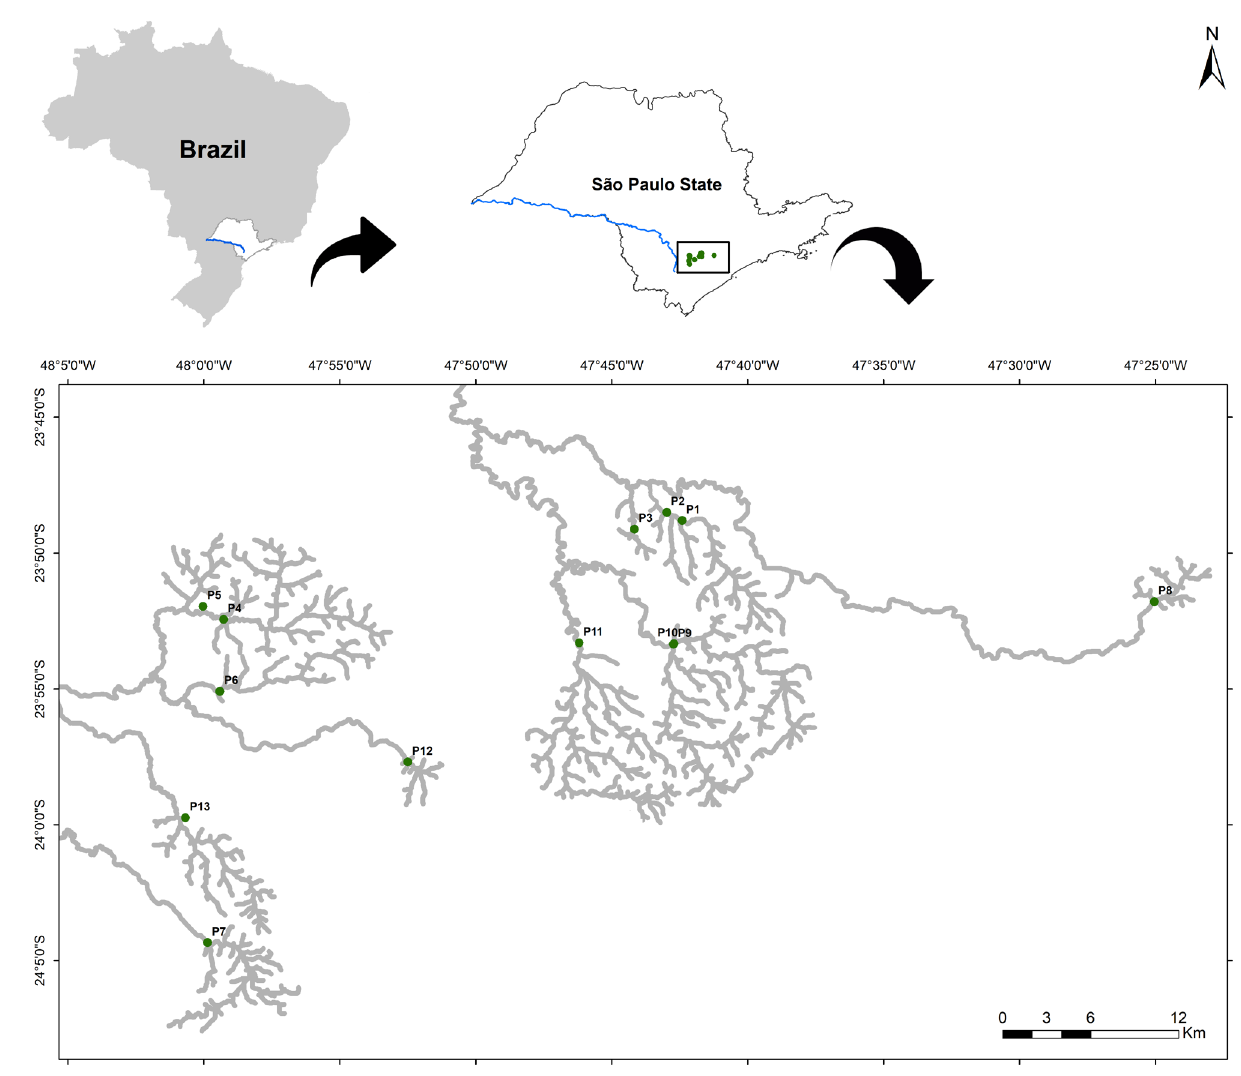
FIGURE 1 | Sampling sites located in the Paranapanema river basin, São Paulo state, Brazil. The Paranapanema river is highlighted in